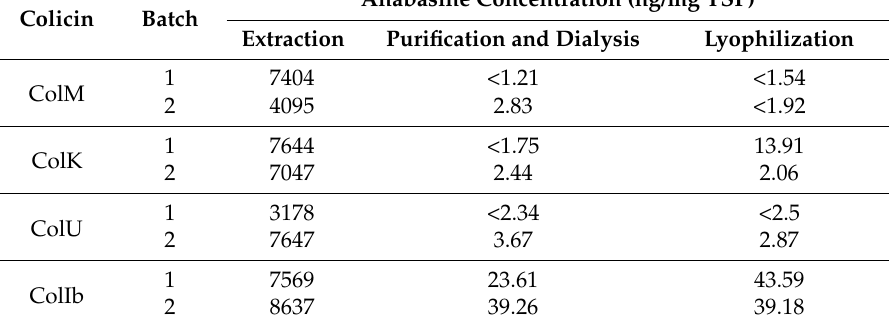
Table 6. Anabasine content of colicin-containing samples during and after purification. Colicin-containing samples were analyzed by HPLC-MS/MS for quantification of anabasine. The analysis was carried out for two batches of each